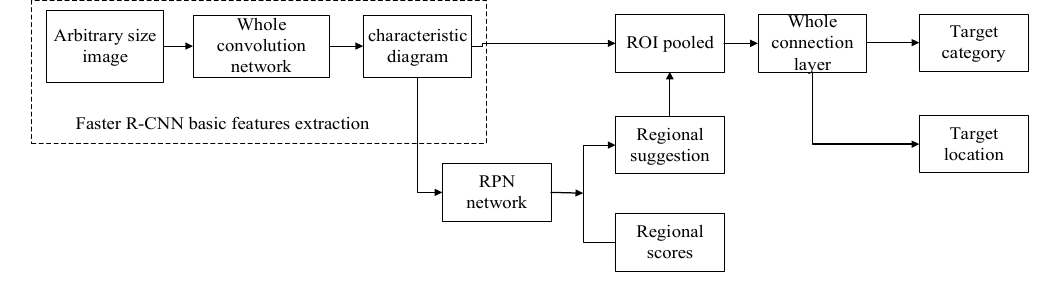
Figure 10. Faster R-CNN algorithm flow.